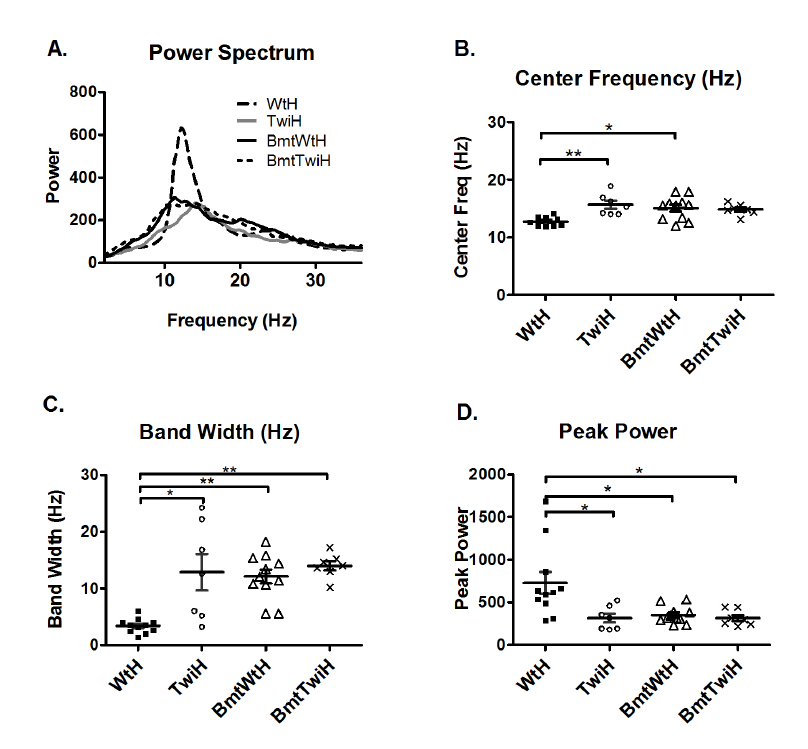
Figure 5. Harmaline tremor response in the BMT-treated animals. Averaged power spectra of various groups treated with harmaline ( A ). The averaged power spectrum of WtH group (solid gray line) appears different compared to the averaged power spectrum of the other groups in ( A ). The averaged power spectra of the BmtWtH (solid black line), TwiH (dashed black line), and BmtTwiH (solid gray line) appear very similar to each other. The center frequency ( B ) and the bandwidth ( C ) were significantly increased in the BmtWtH group (open triangles) compared to the WtH group (filled squares). The peak power ( D ) was significantly decreased in the BmtWtH group compared to the WtH group. There was no significant difference in center frequency, bandwidth or peak power between the TwiH (open circles) and BmtTwiH groups (cross marks). Horizontal bars represent the mean and the error bars represent the SEM (*** p < 0.001, ** p < 0.01 and * p <